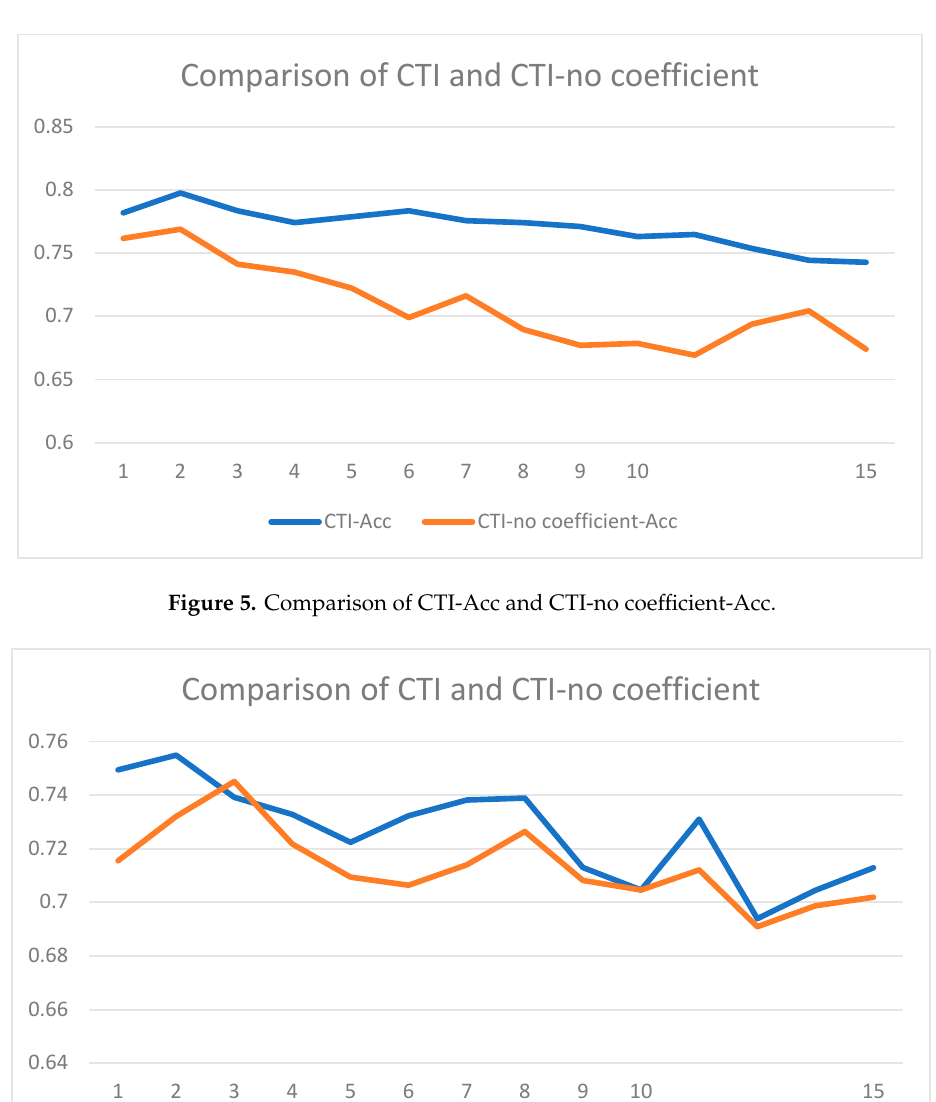
Figure 4. The effect of different coefficients.